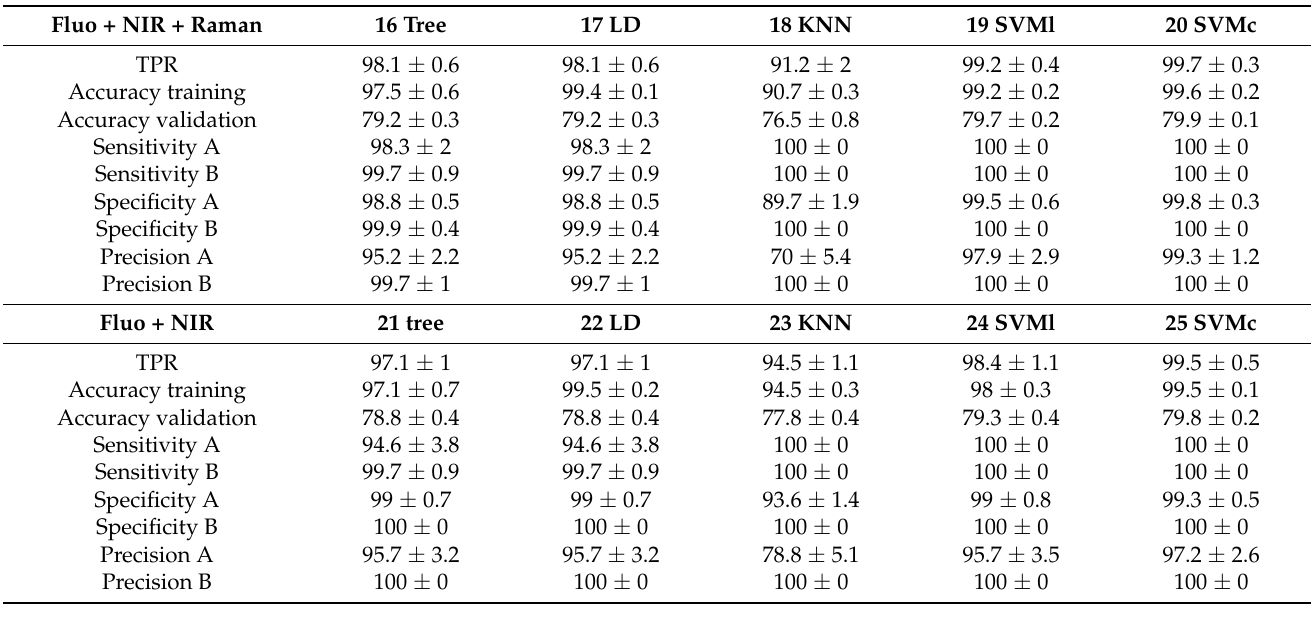
Table 5. Results of the classification of samples with combinations of spectra; means and standard deviations of 10 classifi- cation runs.